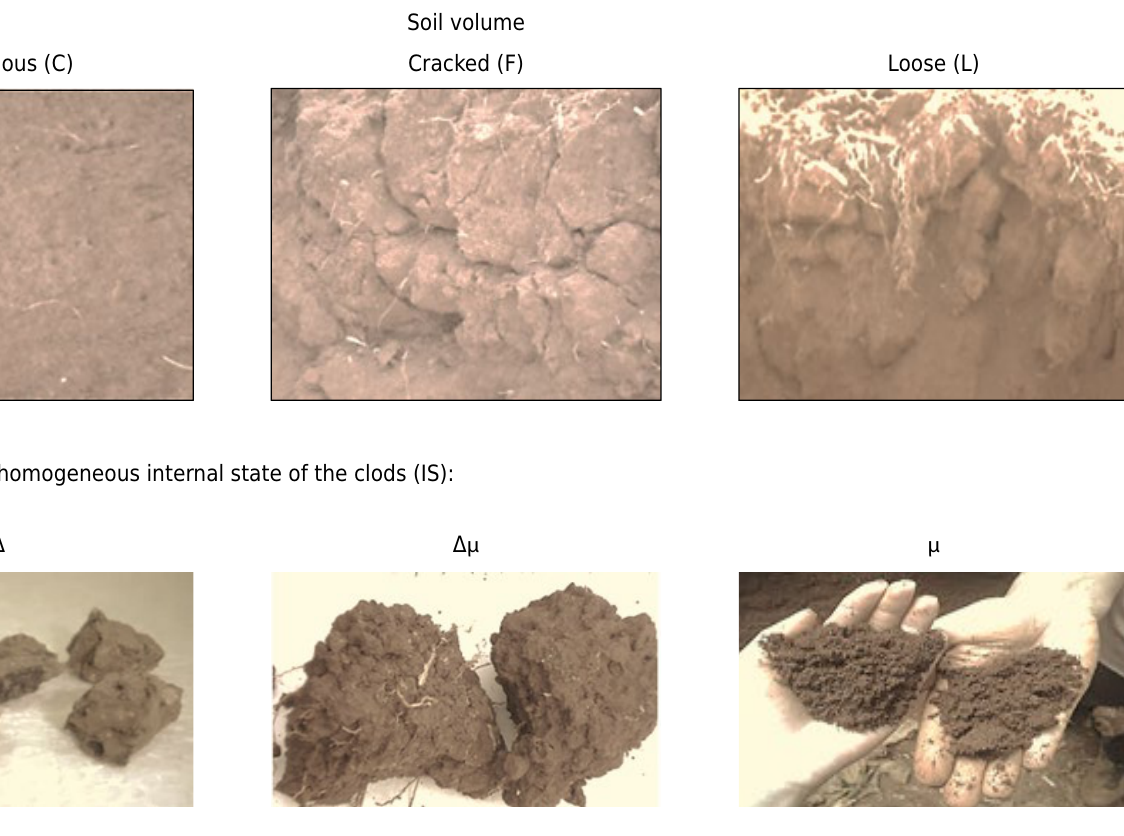
a) Stratification of clod organization in the soil profile